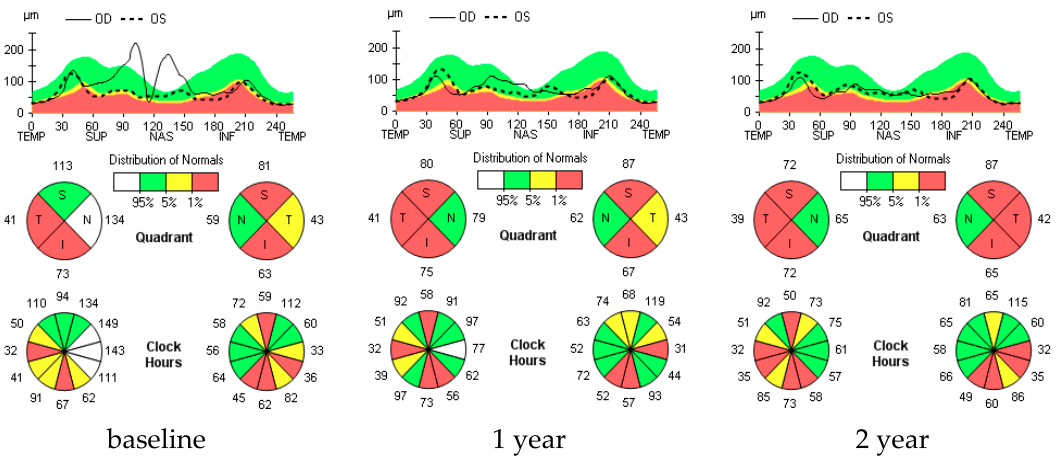
Figure 2. RNFL longitudinal analysis in a selected MS ON + patient. Figure 2 shows progressive and significant RNFL thinning during the follow-up in a selected MS ON + patient. In fact, in the right eye colorimetric map, a significant thinning of the RNFL in the superior peripapillary quadrant is observed, as indicated by the color change toward red, which is appreciable both 1 year and 2 years after the baseline. Similarly, in the left eye, the RNFL-T significantly decreases (turns red) in the temporal peripapillary quadrant at 2